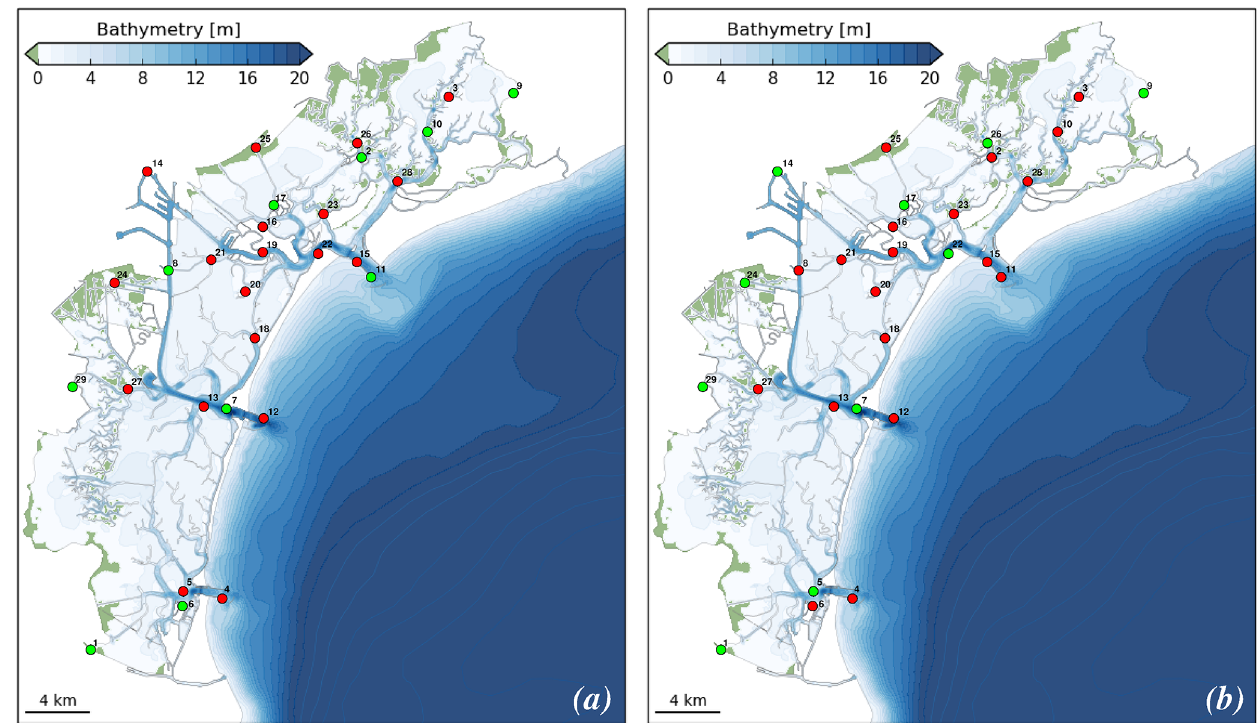
Figure 7. The optimal distribution of 10 tide gauge stations (marked with green dots) according to DA-nudging (a) and DA-EnSRF (b) .